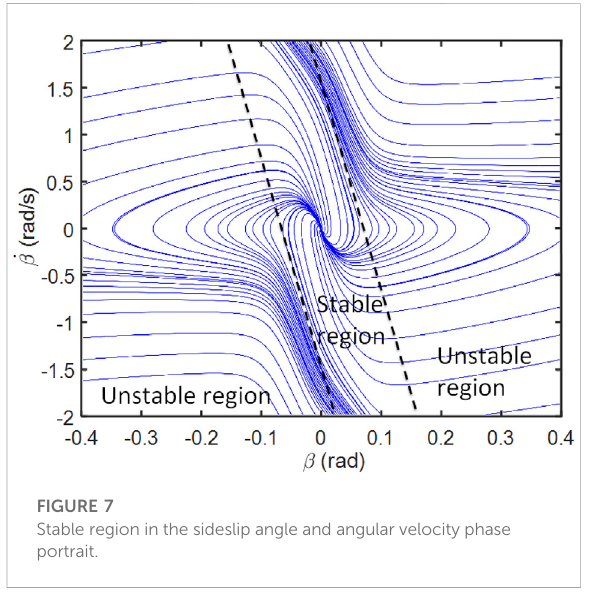
FIGURE 8 Comparison of steering angle.